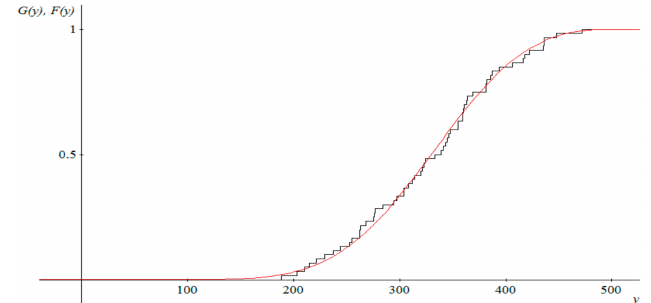
Figure 1. Graph of empirical distribution function (black) ˆ F ( y ) for random variable M 30 for period 2014–2018 in Słubice and graph of matched theoretical distribution function G γµ , σ ( y ) (red). Source: Own study.